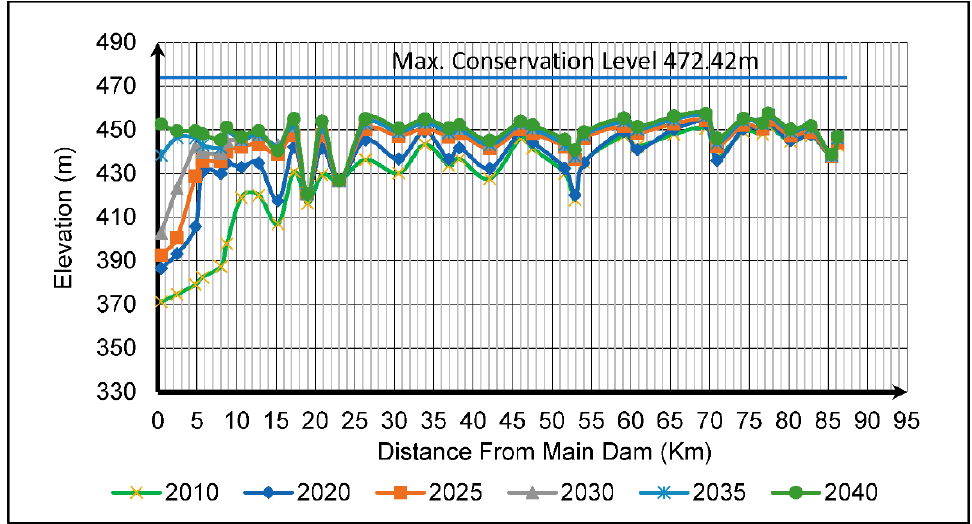
Figure 4. Delta profiles of Tarbela Reservoir [40].